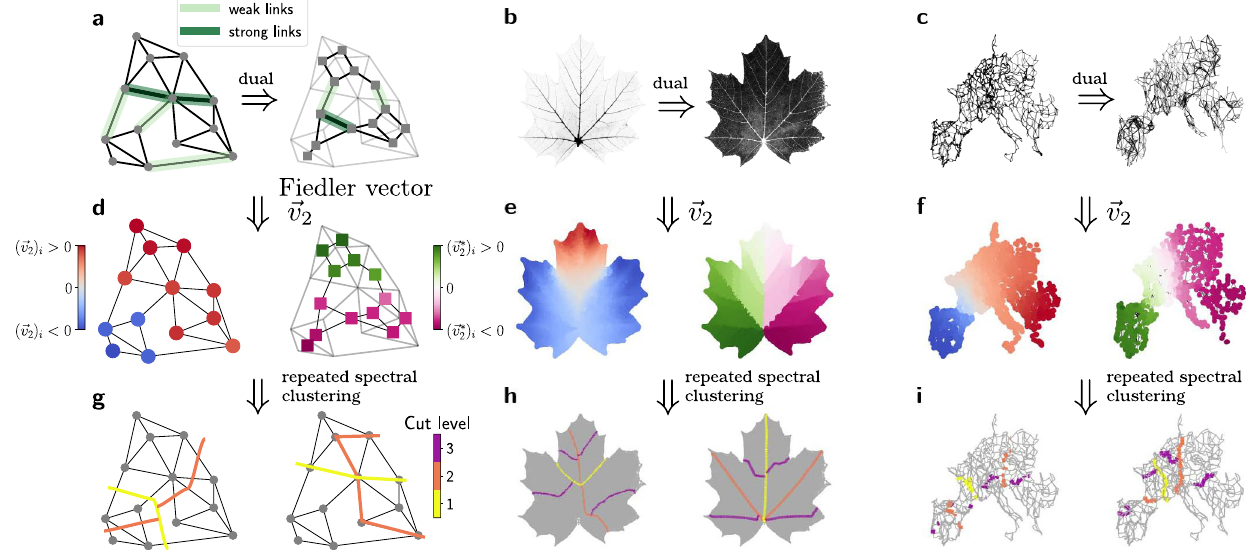
Fig. 2 | Primal and dual communities and hierarchies in spatial networks. a A plane graph with edges characterized by either large (dark green), small (light green)orintermediateedgeweights,anditsassociateddualgraph.Thedualgraph is constructed by transforming each face of the graph into a node of the dual, and addingdualedgeswhenevertwofacesshareanedge.Noticethatanedgewithlarge weight shared by two faces will imply a weak link between the two corresponding nodes in the dual graph (see Eq. (9)). d Spectral clustering by means of the Fiedler vector v 2 reveals the community structure in both the graph (left) and its dual (right). g Basedonrepeatedspectralclustering,thegraphsarefurtherdecomposed into a hierarchy of smaller sub-units which is different in the graph (left) and its